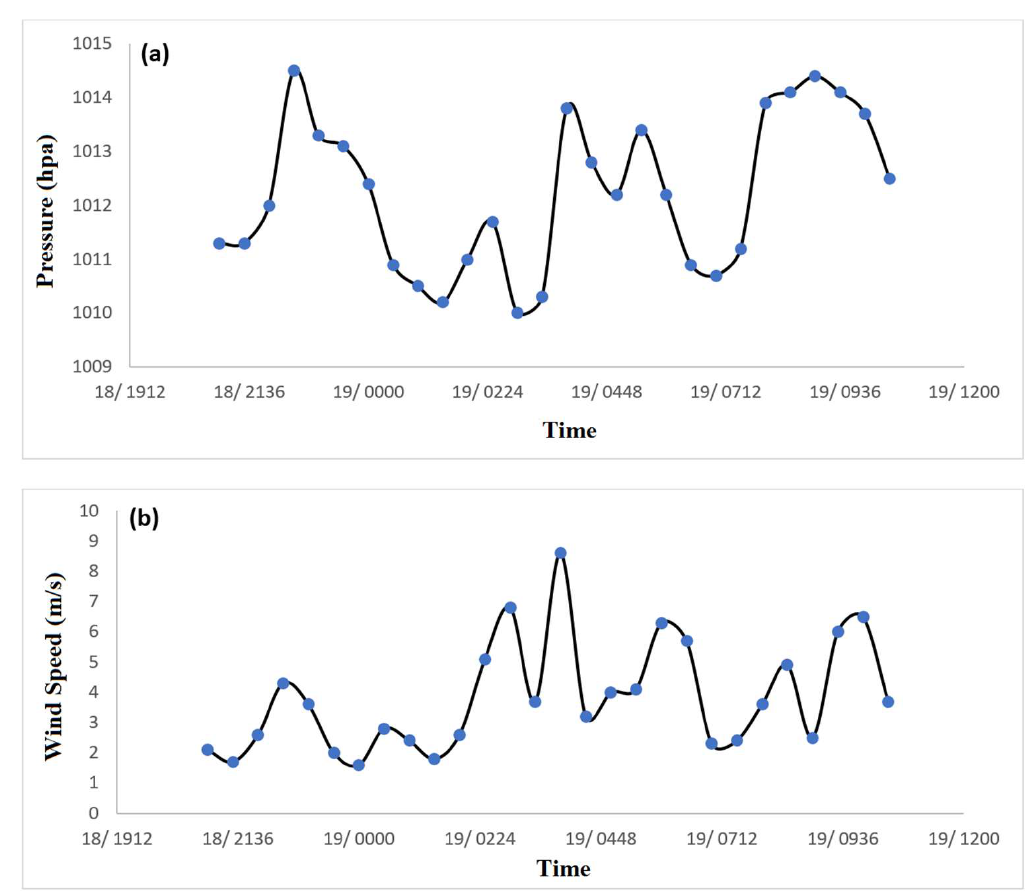
Figure 8. Half hourly pressure ( a ) and wind variations ( b ) at the synoptic station of Bandar Dayyer on 18–19 March before and after the event.